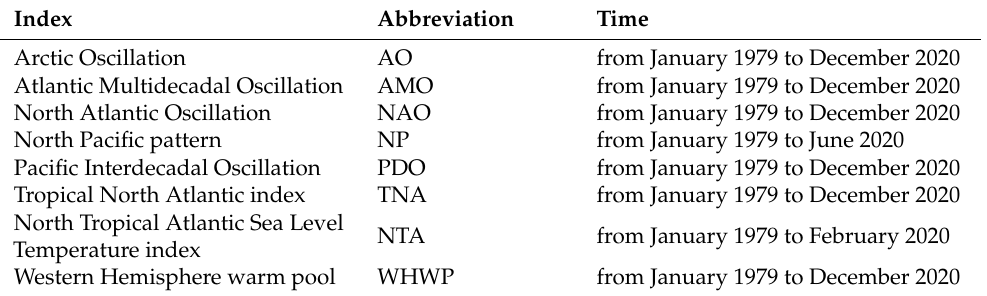
Table 1. Atmospheric circulation indexes used in this